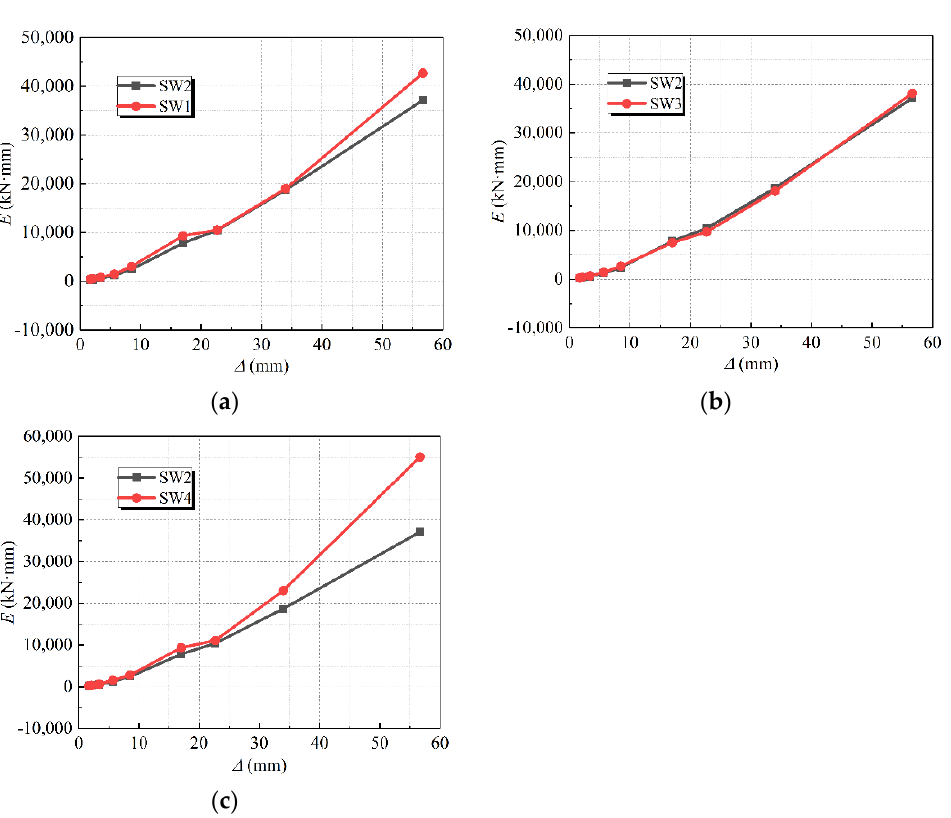
Figure 17. Change of energy dissipation capacity with displacement amplitude. ( a ) Fire exposure time; ( b ) Fire-retardant coating; ( c ) The width-thickness ratio.